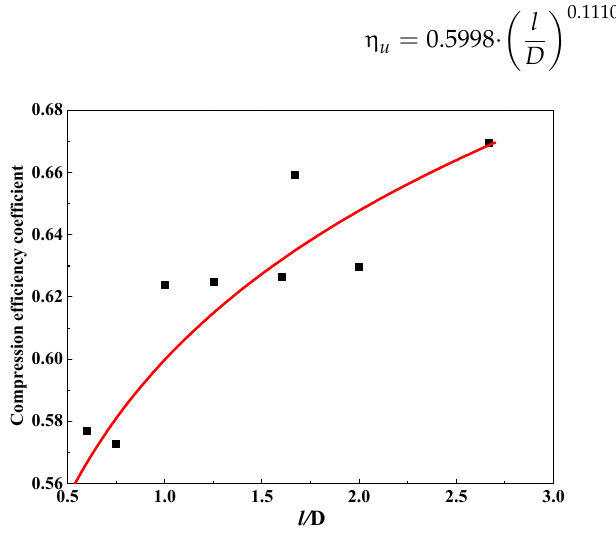
Figure 29. Relationship between pullout efficiency coefficient and blade spacing.